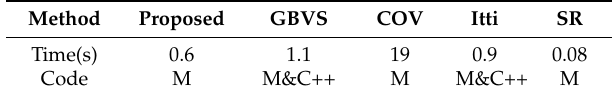
Table 1. The computational run-time(s) of various saliency models under consideration.